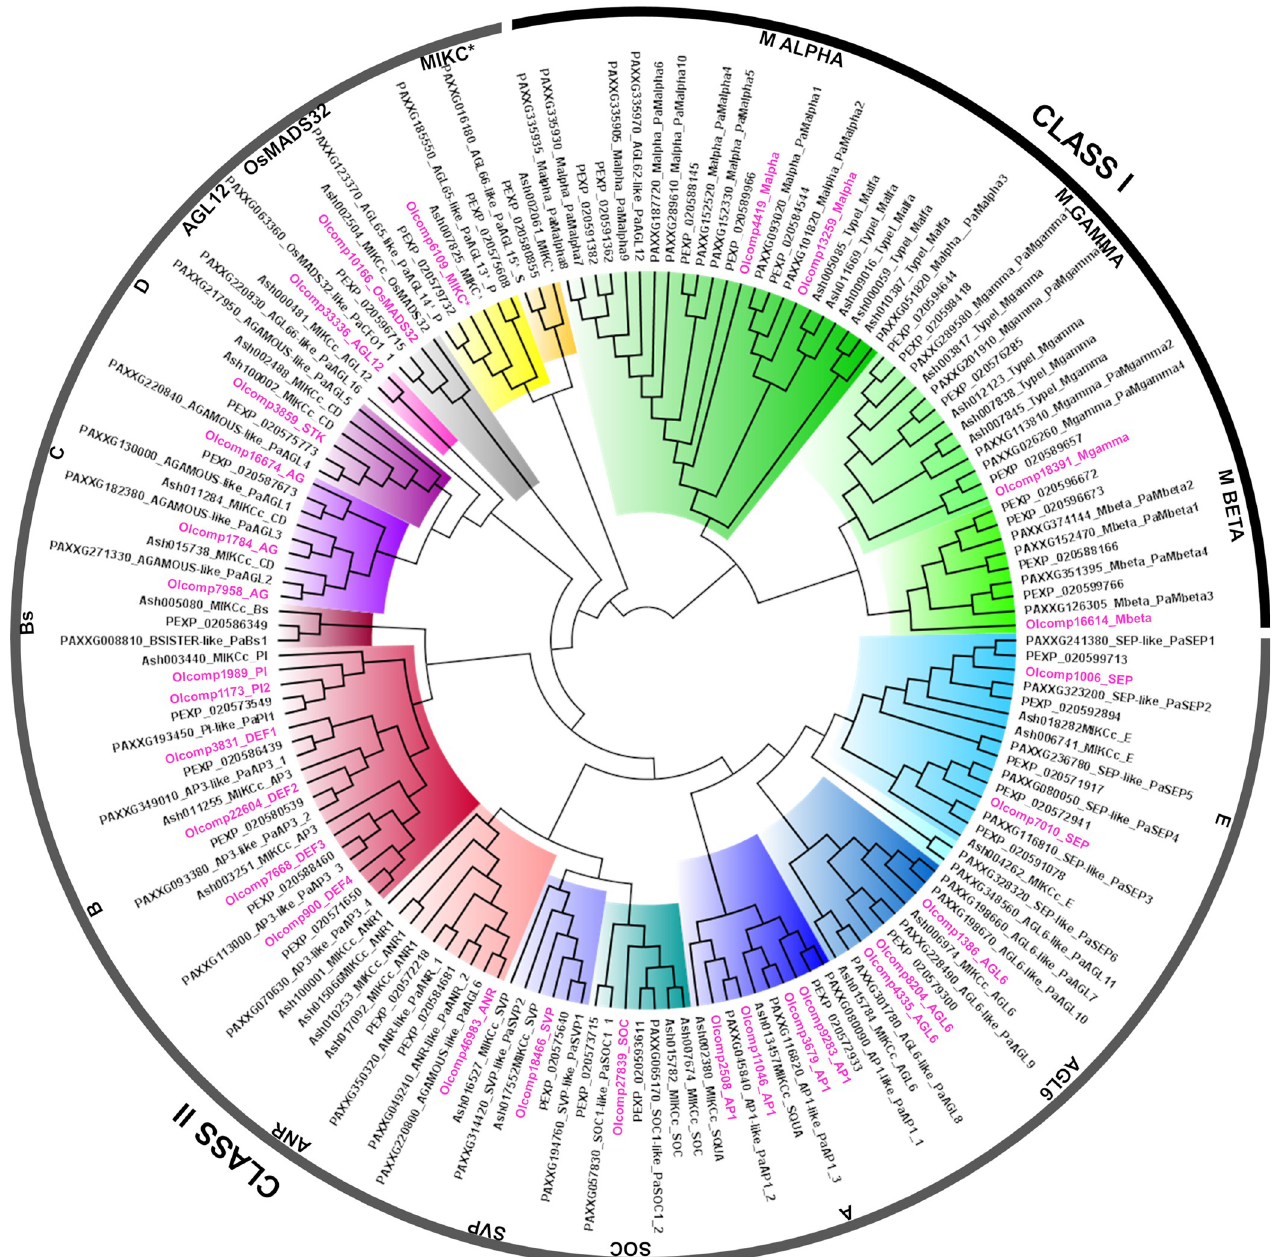
Fig 2. ML tree of the orchid MADS-box proteins. The different classes and groups of MADS-box proteins of O . italica , P . aphrodite , P . equestris and A . shenzenica are highlighted with different colors. The accessions of O . italica are noted in pink.